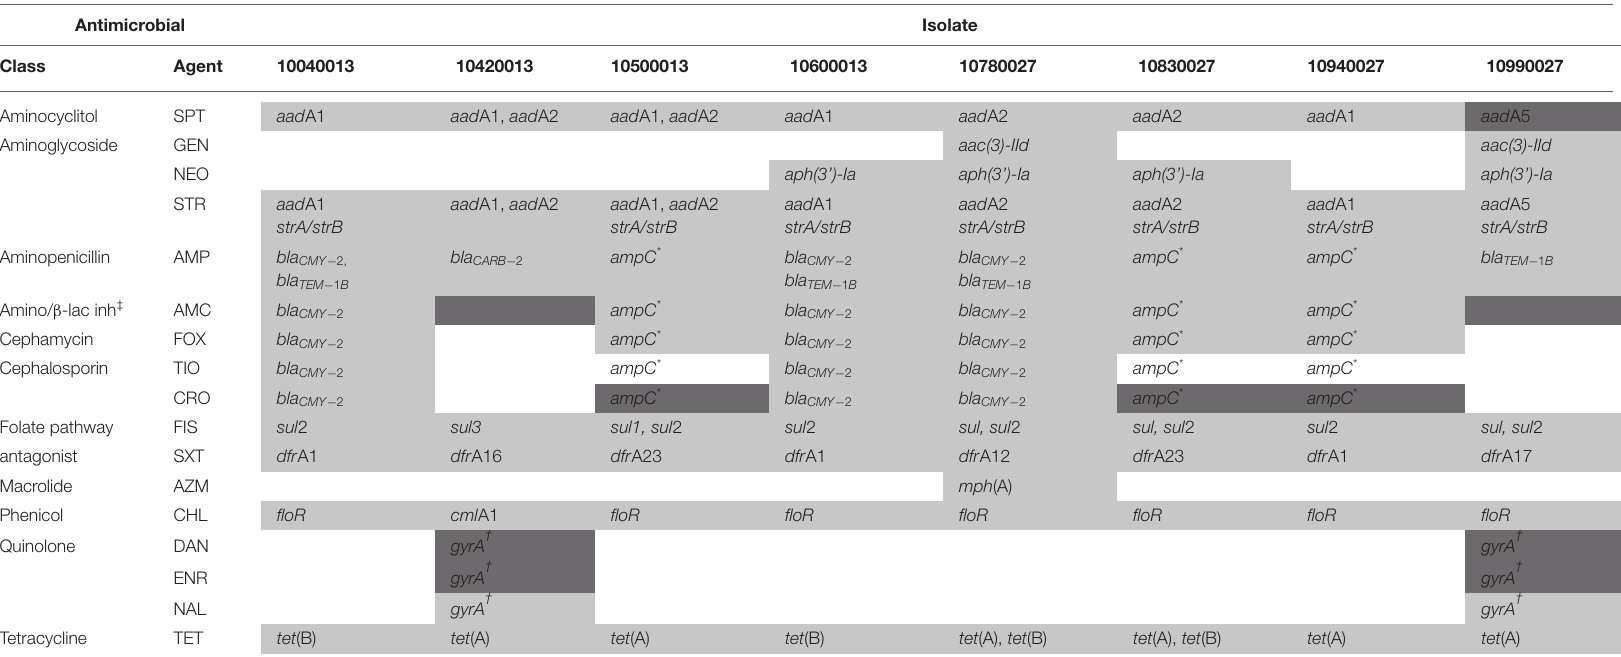
Phenotypic resistance is represented by dark and light gray cells for intermediate and resistant isolates, respectively. White cells are for susceptible isolates. Resistance genes indicated in cells denote their presence for a particular isolate. * Promoter mutation in ampC − 42C - > T; † Mutation in gyrA S83L; ‡ Penicillin + β -lactamase inhibitor. AMC, amoxicillin-clavulanic acid; AMP, ampicillin; AZM, azithromycin; CHL, chloramphenicol; CRO, ceftriaxone; DAN, danofloxacin; ENR, enrofloxacin; FIS, sulfisoxazole; FOX, cefoxitin; GEN, gentamicin; NAL, nalidixic acid; NEO, neomycin; SPT, spectinomycin; STR, streptomycin; SXT, trimethoprim-sulfamethoxazole; TET, tetracycline; TIO,